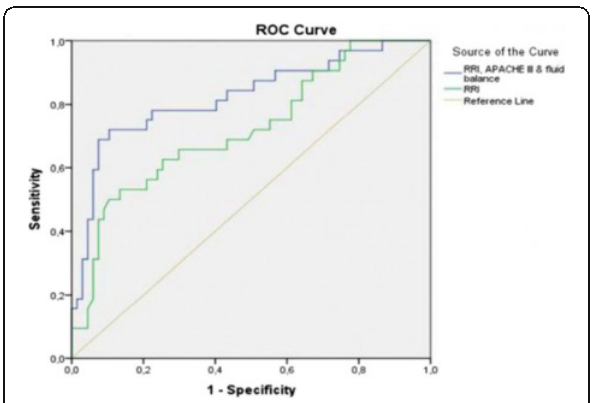
Fig. 13 (abstract A27). ROC curves for AKI stage 2 and